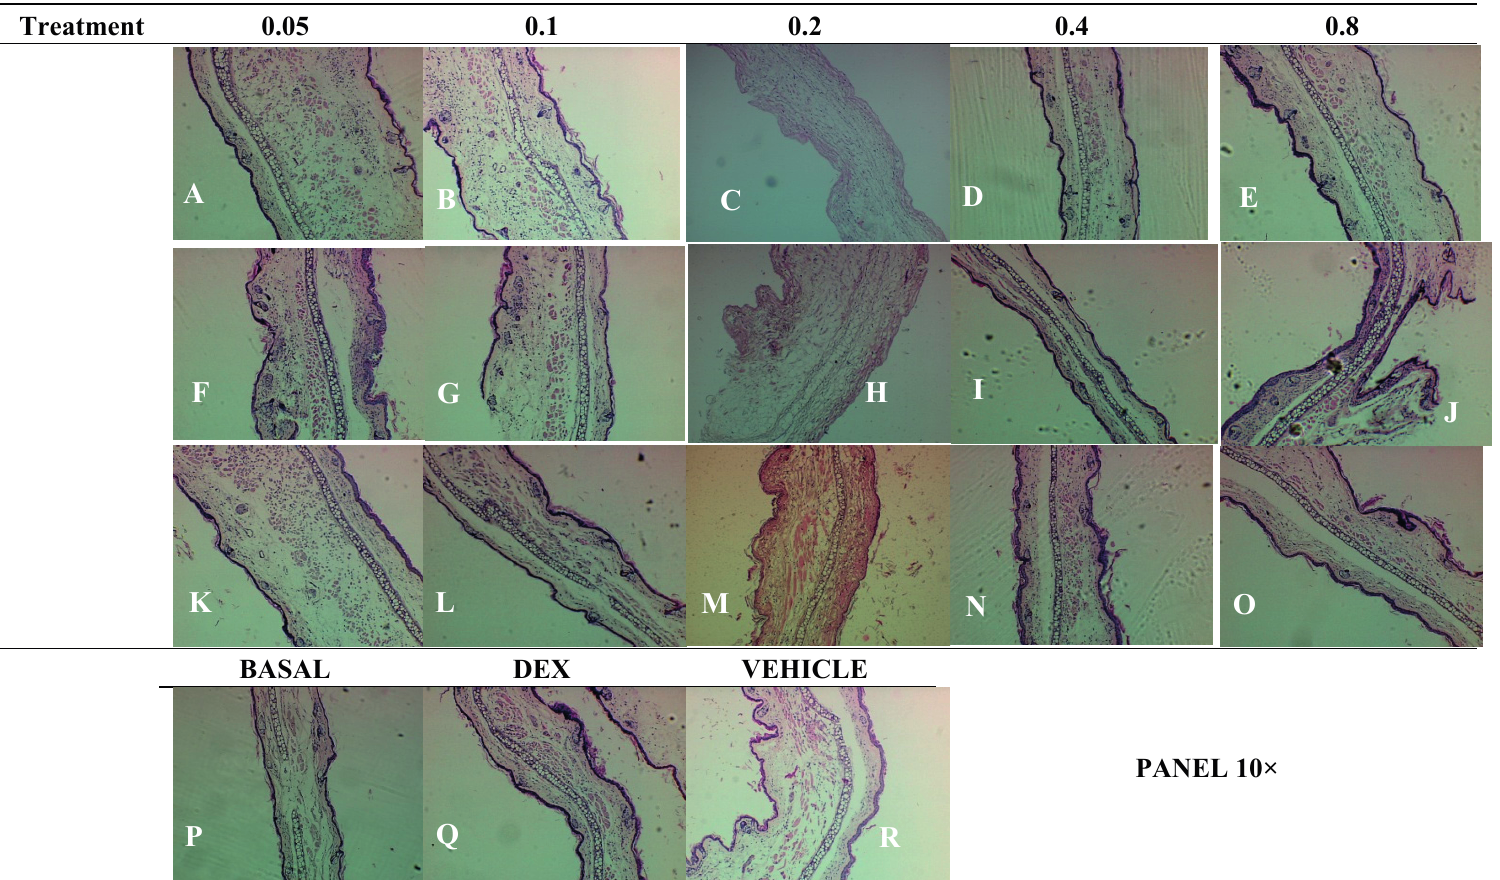
Table 2. Histopathology analysis of alterations induced by TPA and the protector effect of the different concentrations (0.05, 0.1, 0.2, 0.4 and 0.8 mg/ear) of extracts (AaAc, images A – E ), AaF13 (images F – J ) and AaF16 (images K – O ) fractions from Agave angustifolia . BASAL = NO-TPA, DEX = dexamethasone and VEHICLE (ears with